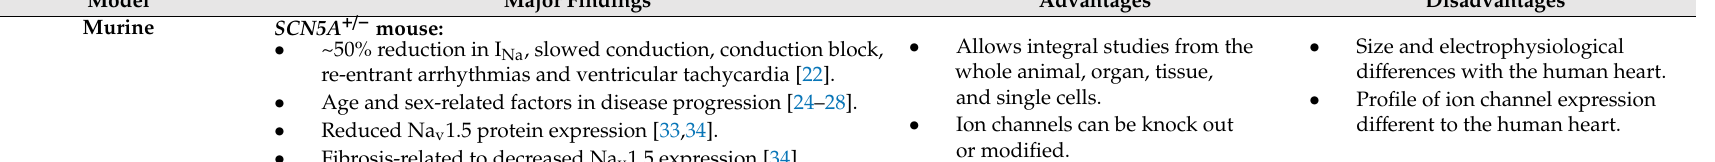
Table 1. Summary of the main findings, advantages, and disadvantages of the experimental models used for studying Brugada syndrome.